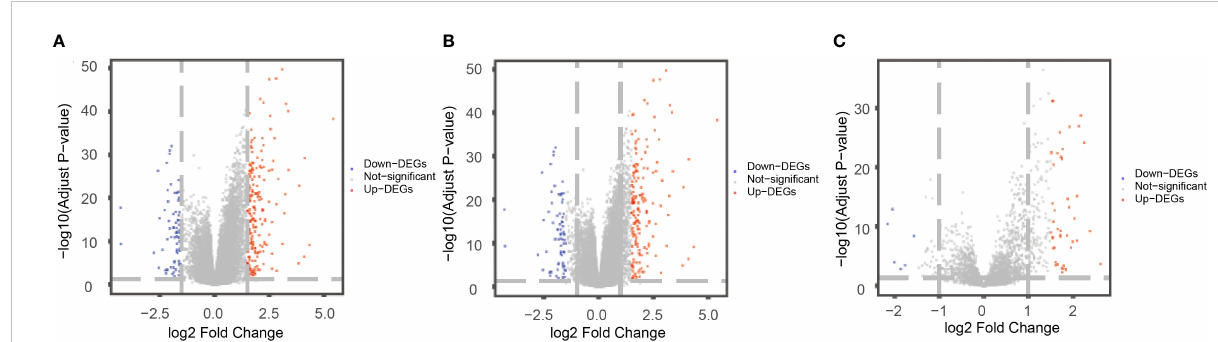
FIGURE 8 Differentially expressed mRNAs (A) , miRNAs (B) , lncRNAs (C) between patients in a high-risk group and a low-risk group. The horizontal axis was logFC; the vertical axis was -log10 (Adjust P-value). Red nodes represent up-regulated differentially expressed genes, blue nodes represent down- regulated differentially expressed genes, and gray nodes represent genes that were not signi fi cantly differentially expressed.